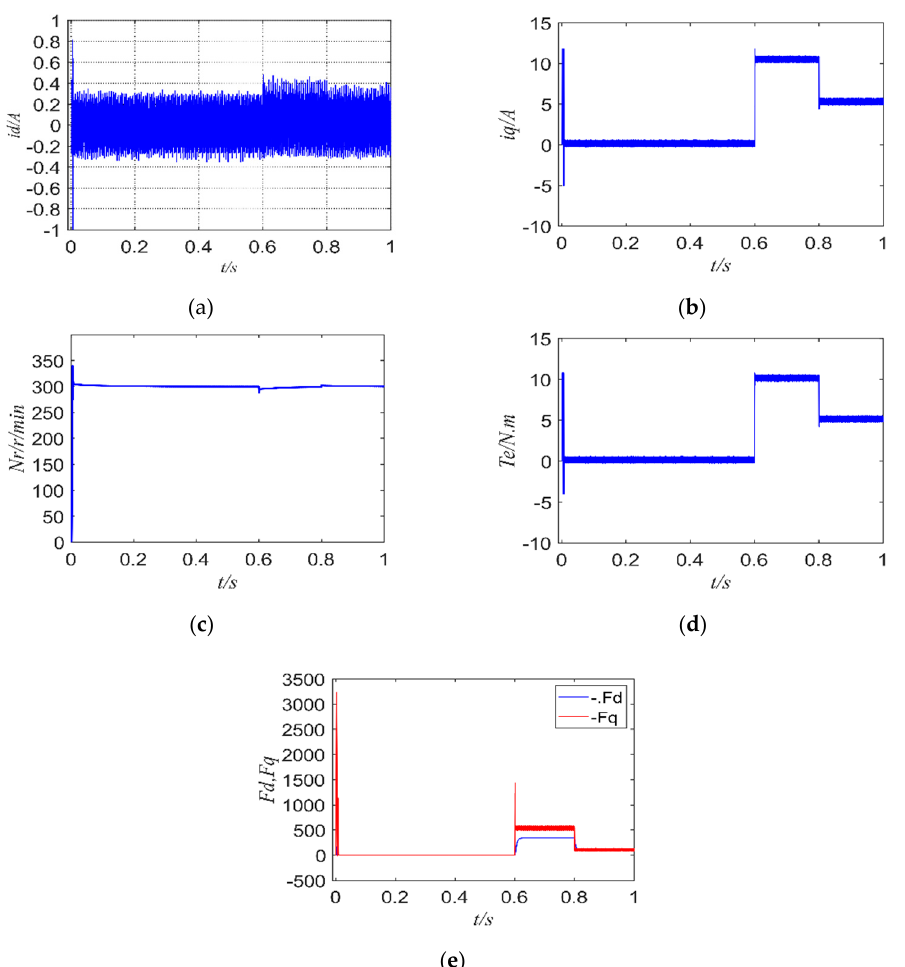
Figure 14. FCS-MPCC simulation results under normal parameters when the sampling period is 50